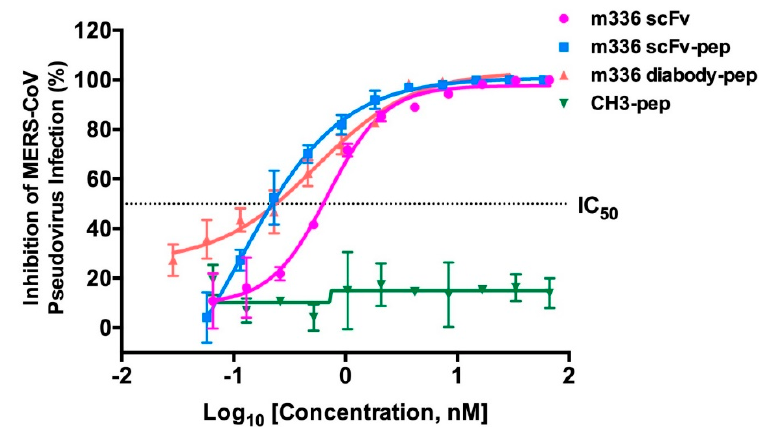
Figure 3. Potent neutralization of MERS-CoV by anti-MERS-CoV inhibitors. Pseudotyped virus was incubated with proteins before infection of DPP4-expressing Huh-7 cells. Luciferase activities were measured, and percent neutralization was calculated.